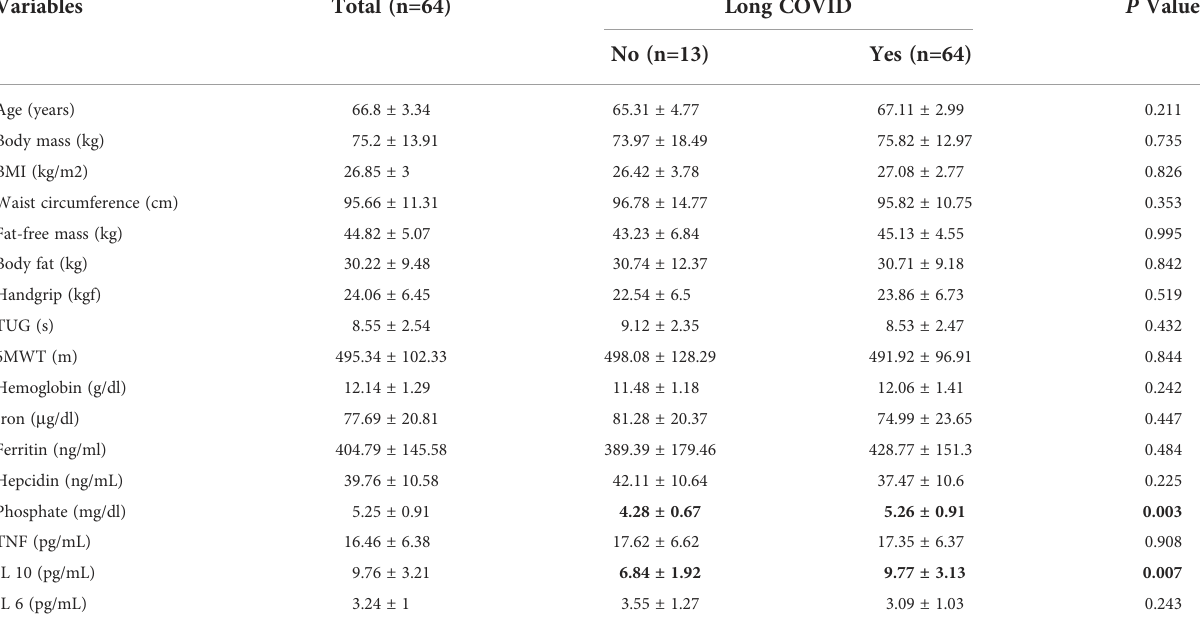
TABLE 1 Baseline characteristics strati fi ed by the presence of long